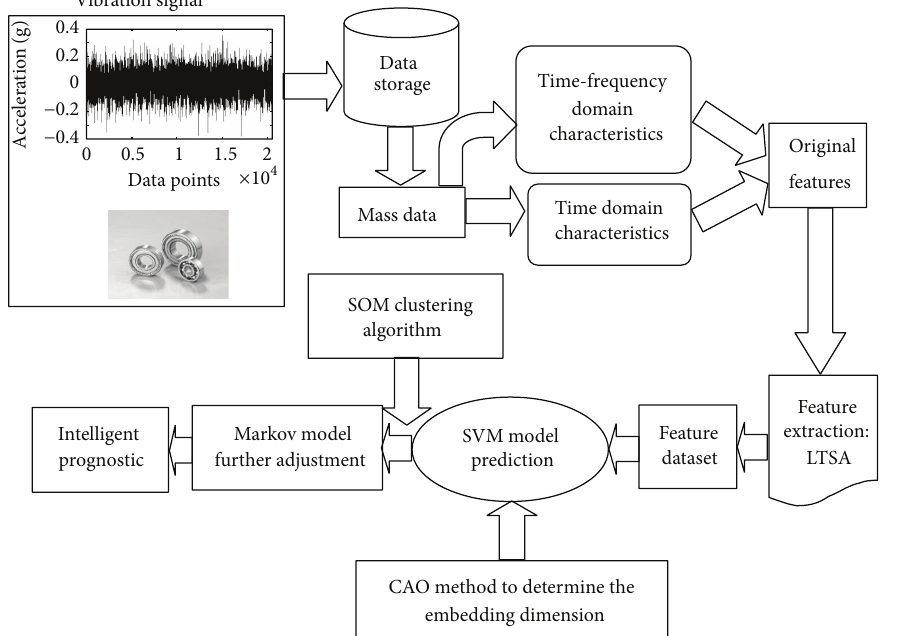
Figure 1: The flowchart of the proposed